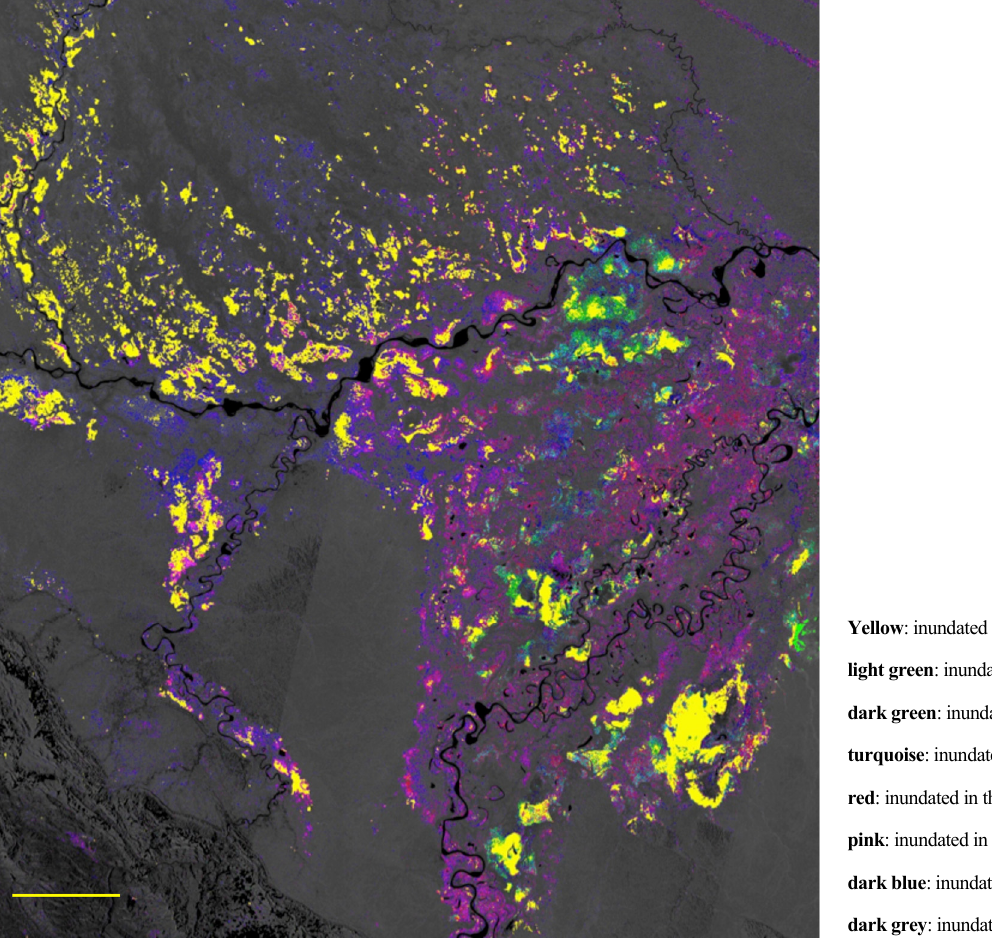
Figure 14. Inundation duration (for vegetated areas) estimated from seven images acquired between 2007 and 2008 from a single orbit path for the Pacaya-Samiria Reserve (area “c” in Figure 3) and surrounding areas in Peruvian Amazon. The area shown spans 300 km from east to west and 350 km from north to south. The yellow bar shows 50 km scale. Background is low contrast multi-temporal image